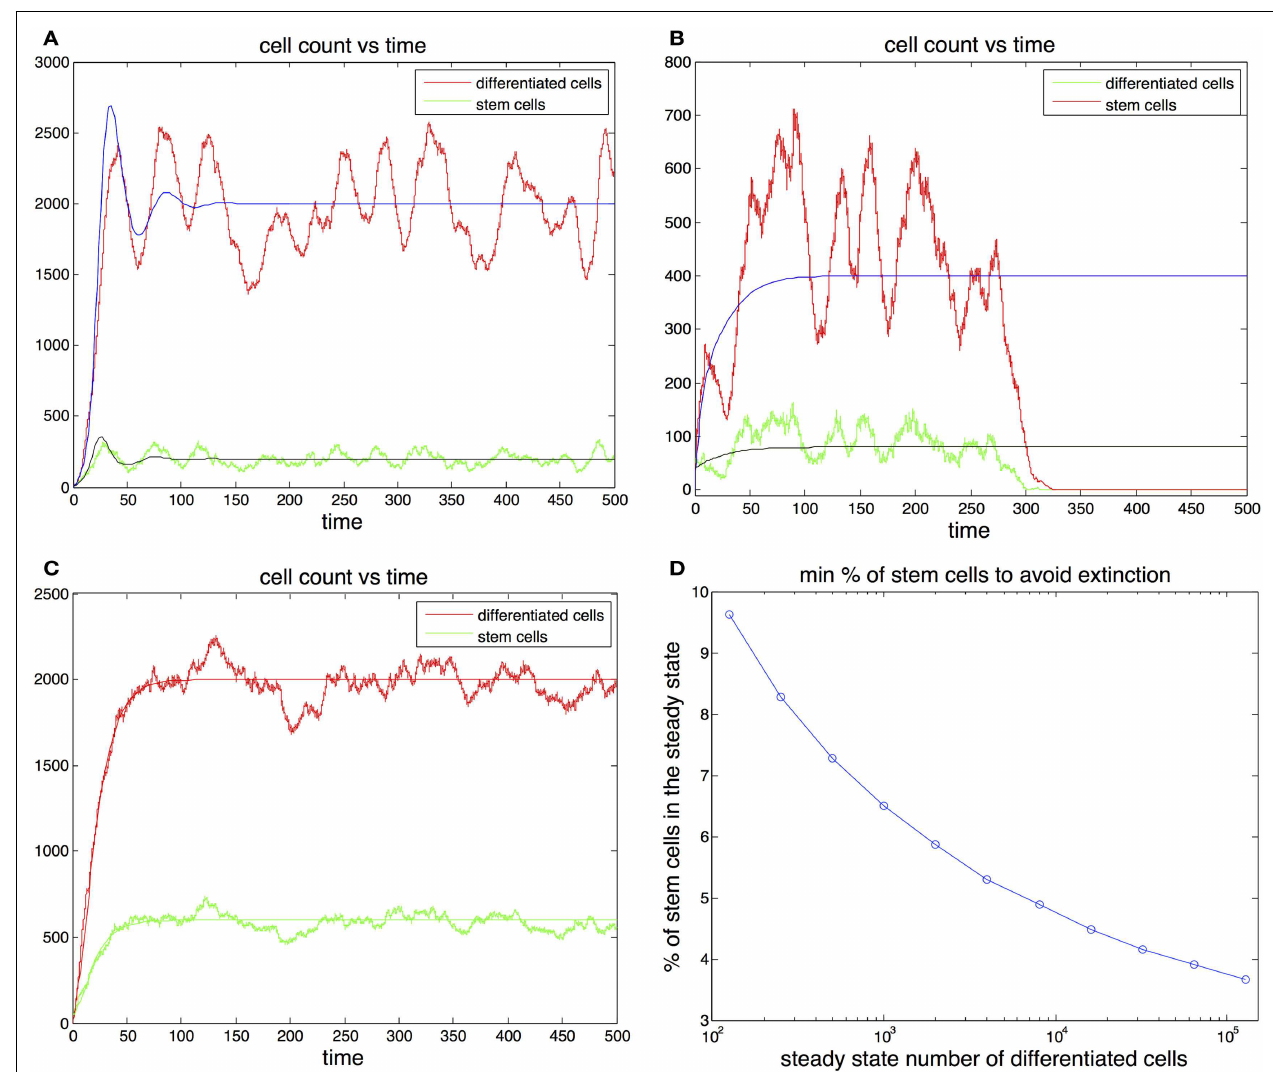
the survival of the population in the ode model. Let us call the curve in the graph y( ˇD ).Then for any set of parameters that satisfy (2 p 0 − 1)/ g = ˇD , p 0 ∈ (0.5,0.9) and the steady state fraction of stem cells f (cid:61) y( ˇD) , the initial conditions S (0) = 1 , D (0) = 0 guarantee the survival of the population. For example, for all ˇD (cid:61) 10 3 if p 0 (cid:53) 0 . 9 and the steady state fraction of stem cells f (cid:61) 0.064 survival is guaranteed for any level of feedback on the division rate. (These conditions are sufficient but not